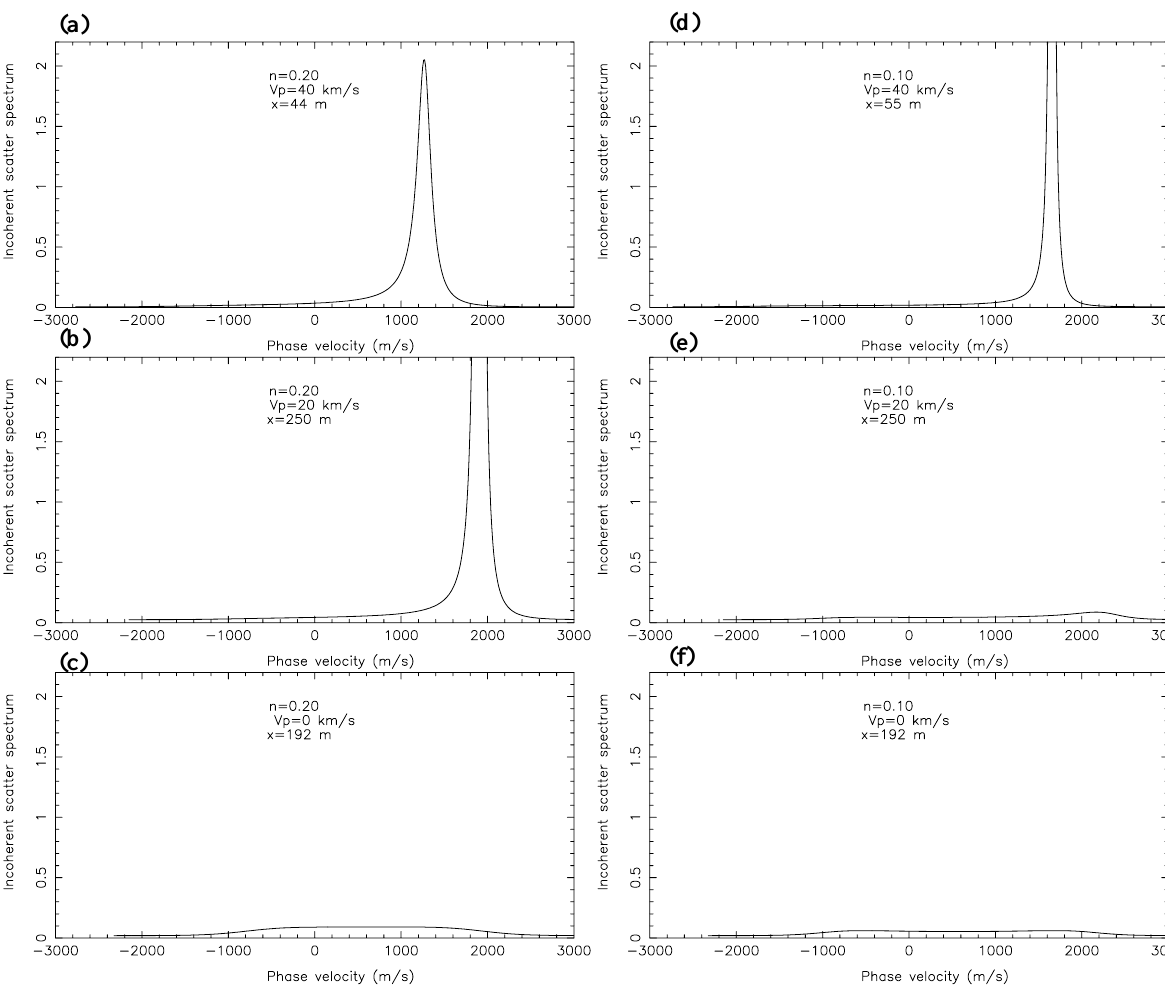
Fig. 12. The incoherent scatter spectra for the EDFs shown in Fig.